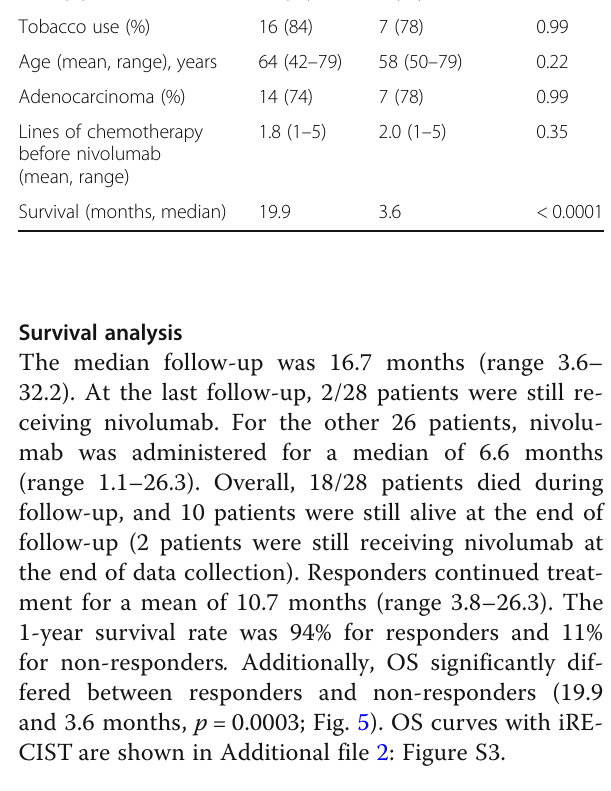
iPERCIST responders